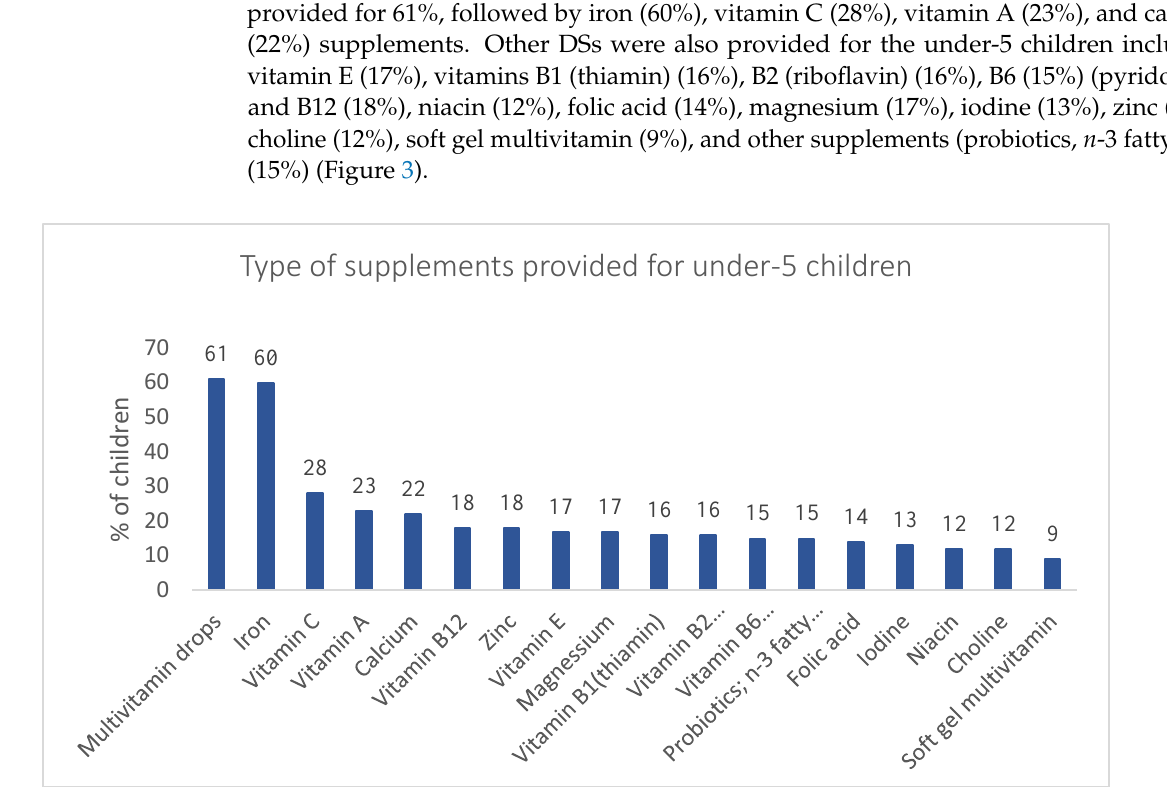
Figure 3. Types of supplements provided for under-5 children.